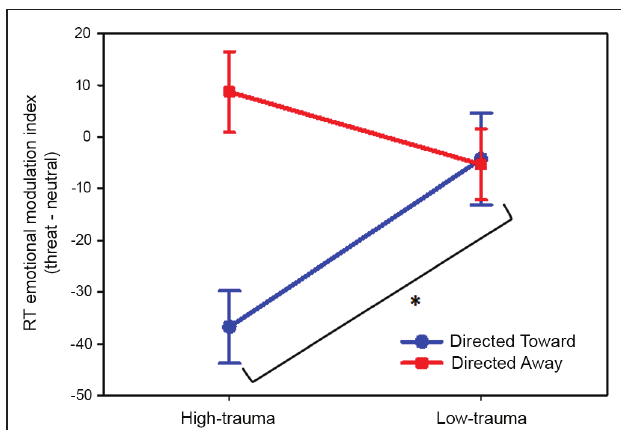
FIGURE 4 | Effect of violent crime trauma load on the emotional modulation produced by threat pictures. Values represent the threat emotional modulation index per block. Participants were divided into high- and low-trauma groups. In all cases, the mean values are reported in ms and are plotted with error bars indicating the SEM. * Indicates a significant